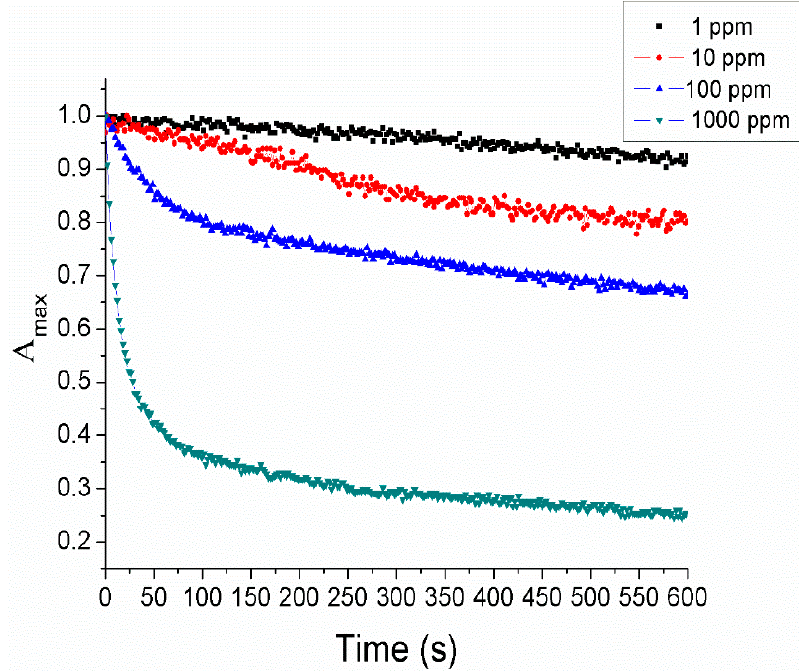
Figure 6. Evolution of the normalized maximum absorbance at 435 nm related to the Localized Surface Plasmon Resonance (LSPR)absorption band of the AgNPs when the sensitive region is immersed in different hydrogen peroxide concentrations of 1 ppm (black), 10 ppm (red), 100 ppm (blue), and 1000 ppm (green), respectively.